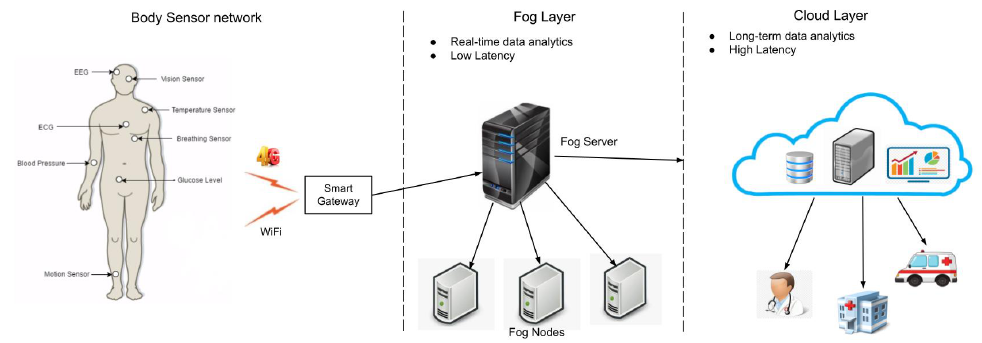
Figure 8. Fog data analytics in healthcare.